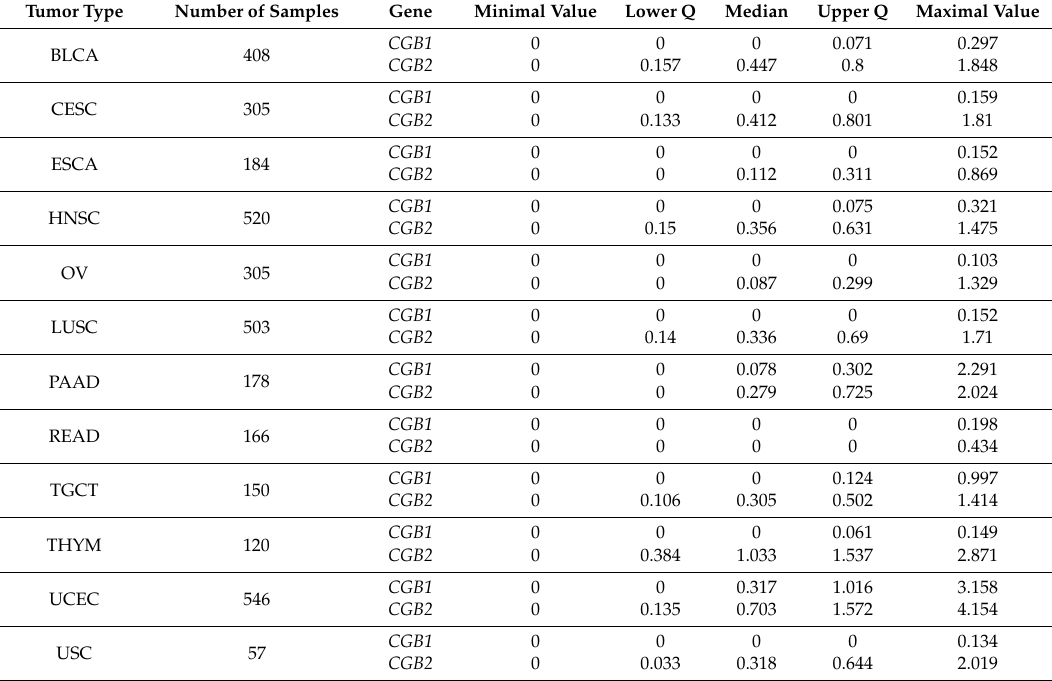
Table 3. The comparison of CGB1 and CGB2 expression in non-malignant and cancerous tissues according to The Cancer Genome Atlas (TCGA) database data.